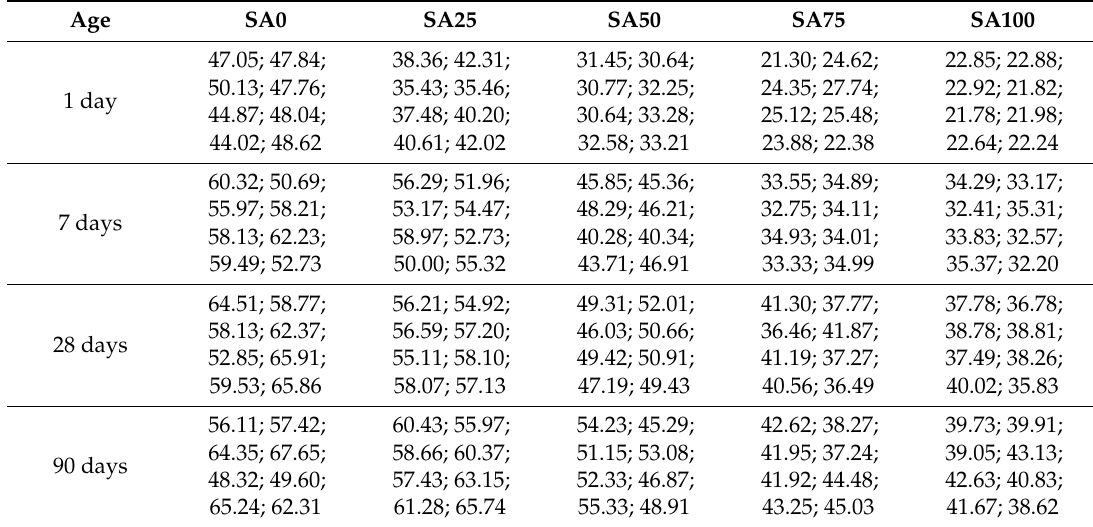
Table 7. Compressive strength (MPa) values by mix and by